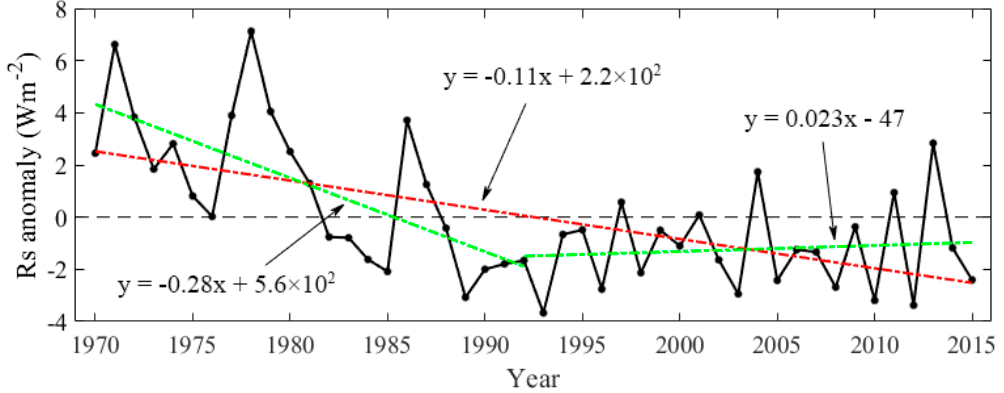
Figure 11. The anomaly of the annual mean Rs in China during 1970–2015. The green dashed lines